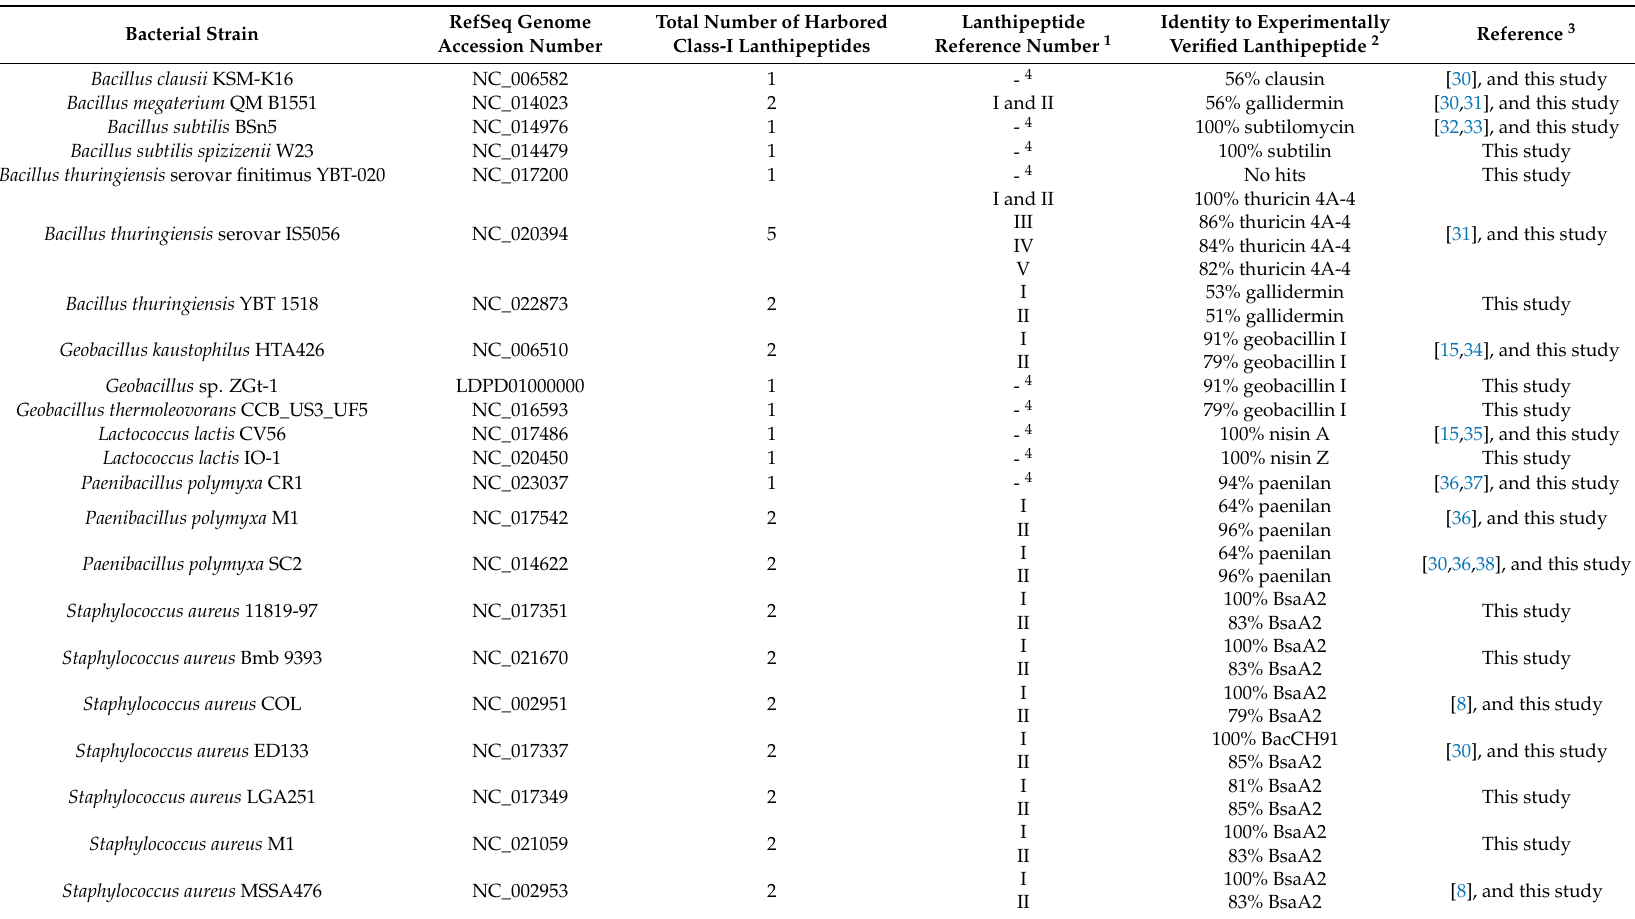
Table 2. Bacterial strains with predicted lanthipeptide production potential, representing possible subjects for future experimental investigations. Strains typed in bold belong to a firmicute species that has not been reported in literature as a producer of class-I lanthipeptides, but the lanthipeptide production potential of its presented strains has been addressed in the current